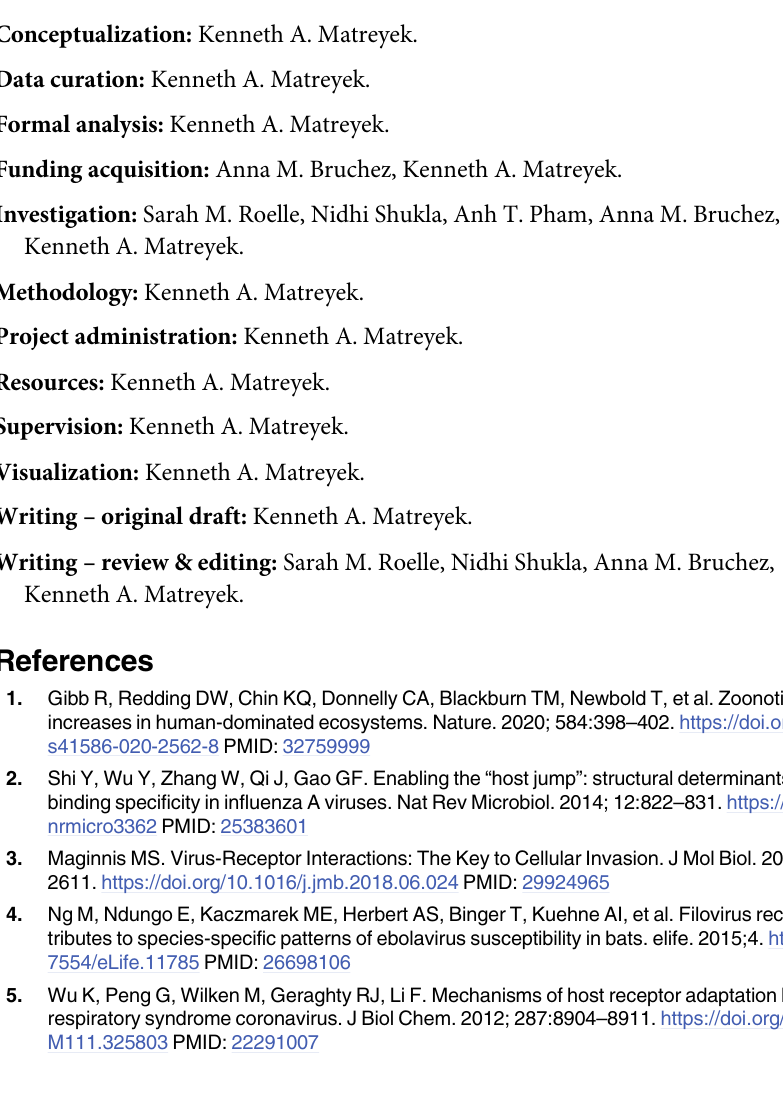
figure. (XLSX) S1 Raw Images. PDF displaying the raw unmodified image files as well as size marker over- lays for each western